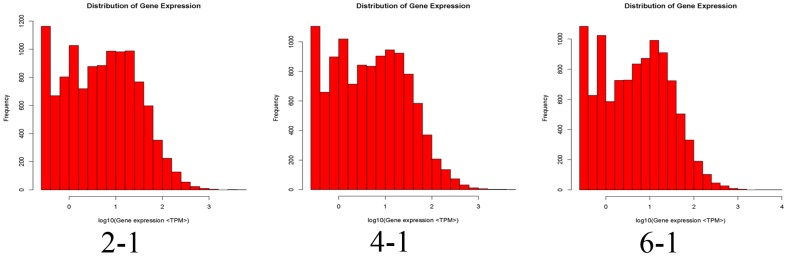
The level of gene expression for each gene (a: sample 2-1, b: sample 4-1, c: sample 6-1).Gene expression level was determined by calculating the number of unambiguous tags for each gene and then normalizing to TPM (transcript copies per million tags).